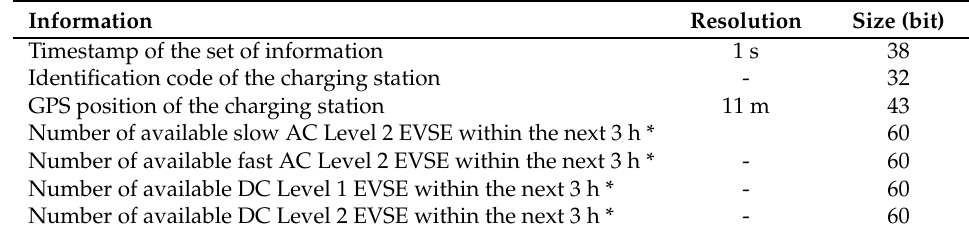
Table 3. List of information packed into each data sample transferred by the EV-MSP to EVs for EVSE monitoring applications, per each monitored charging station. EV: Electric Vehicle, EV-MSP: EV Mobile Service Provider, EVSE: EV Supply Equipment, AC: Alternating Current, DC: Direct